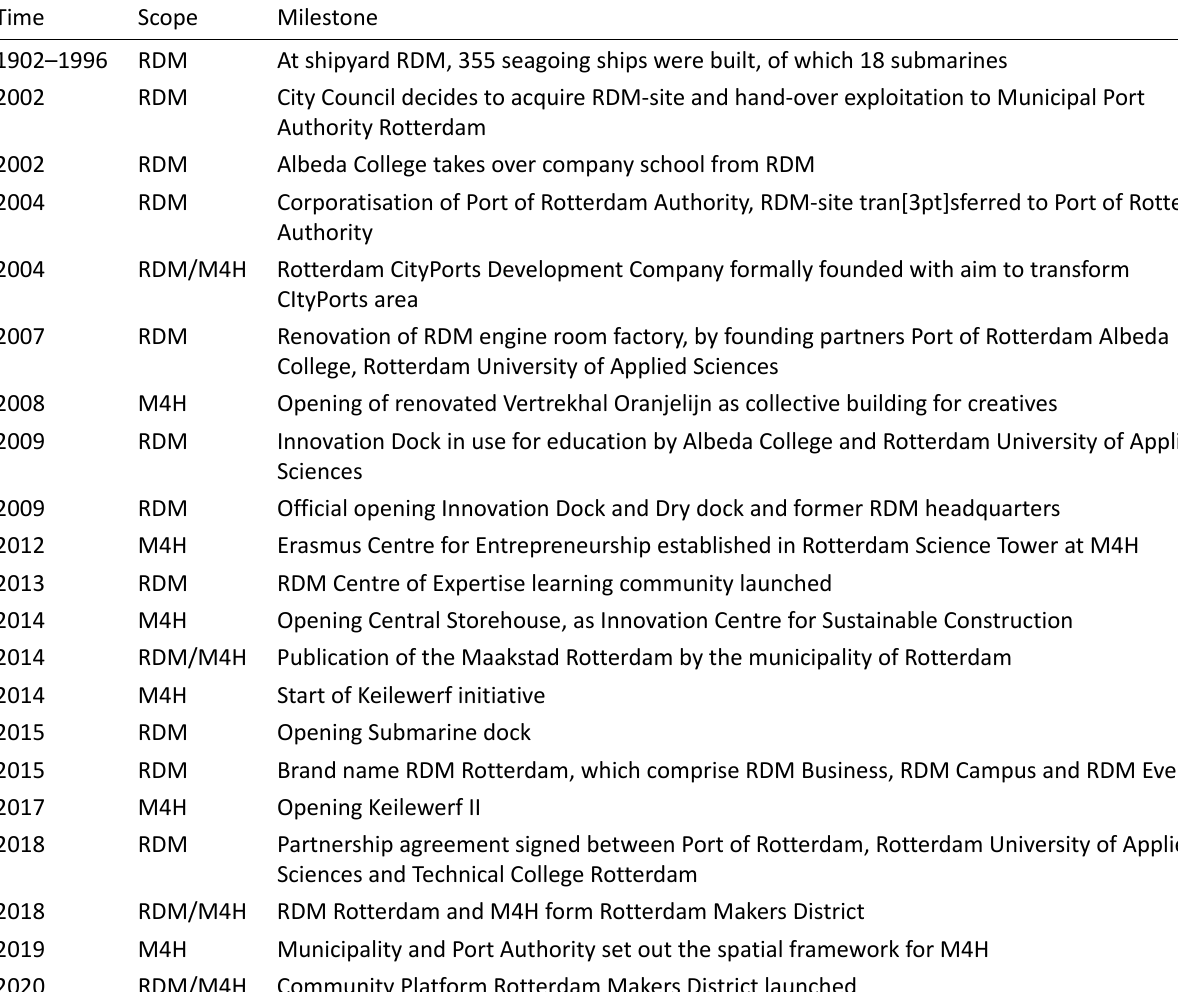
Table 1. Timeline of key events in the area currently designated as Rotterdam Makers